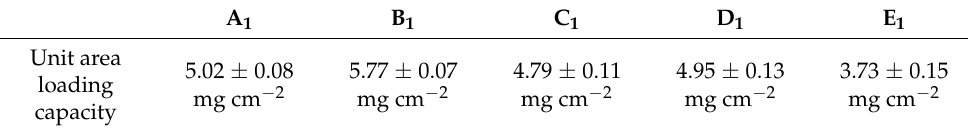
Table 1. List of the unit area loading capacity of different material electrodes.